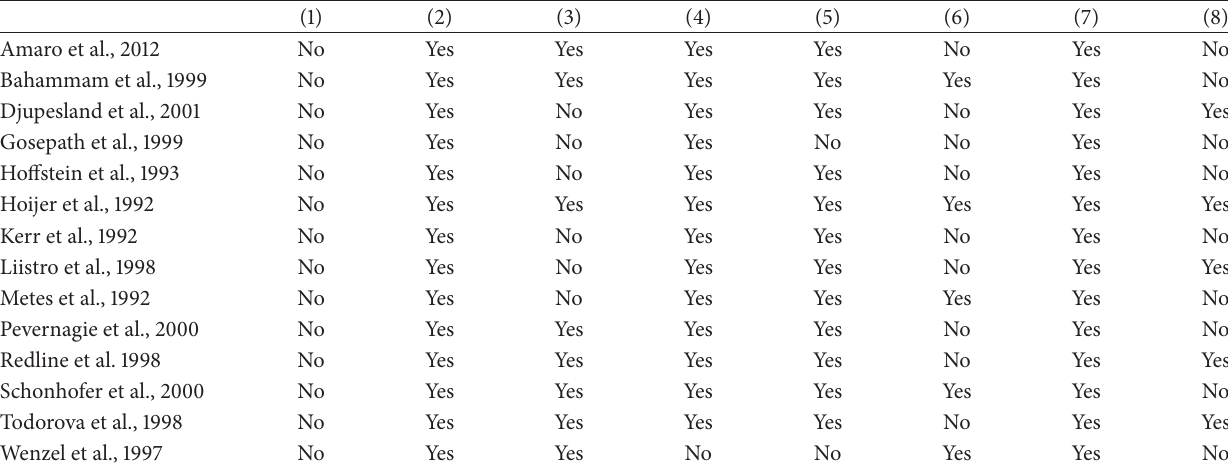
Table 1: General characteristics and quality criteria of included studies. Quality assessment of case series studies checklist from National Institute for Health and Clinical Excellence (NICE). (1) Was the case series collected in more than one center, that is, multicenter study? (2) Is the hypothesis/aim/objective of the study clearly described? (3) Are the inclusion and exclusion criteria (case definition) clearly reported? (4) Is there a clear definition of the outcomes reported? (5) Were data collected prospectively? (6) Is there an explicit statement that patients were recruited consecutively? (7) Are the main findings of the study clearly described? (8) Are outcomes stratified (e.g., by abnormal results, disease stage, and patient